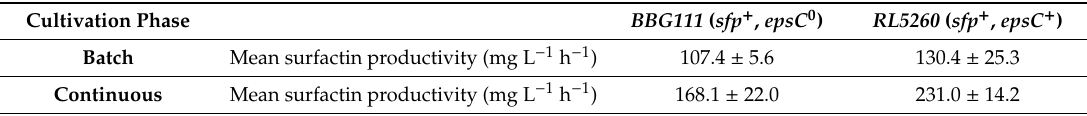
Table 3. Surfactin productivity of the two B. subtilis 168 strains measured in the bulk medium during batch and continuous cultivation.